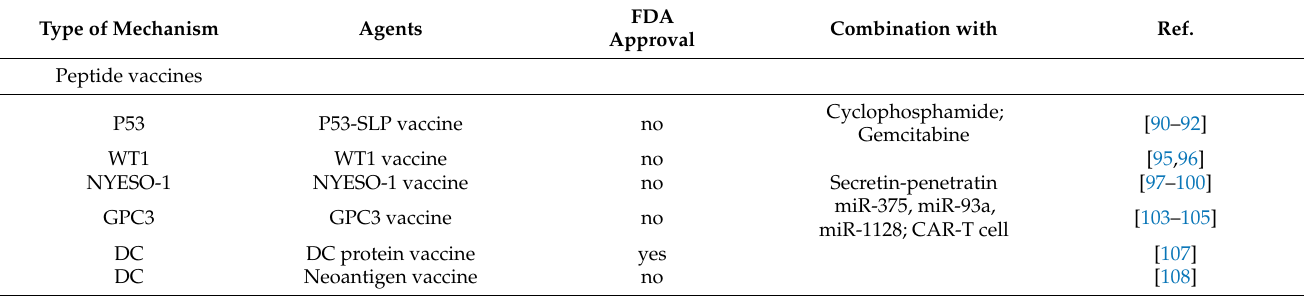
Table 2. Immunotherapies for